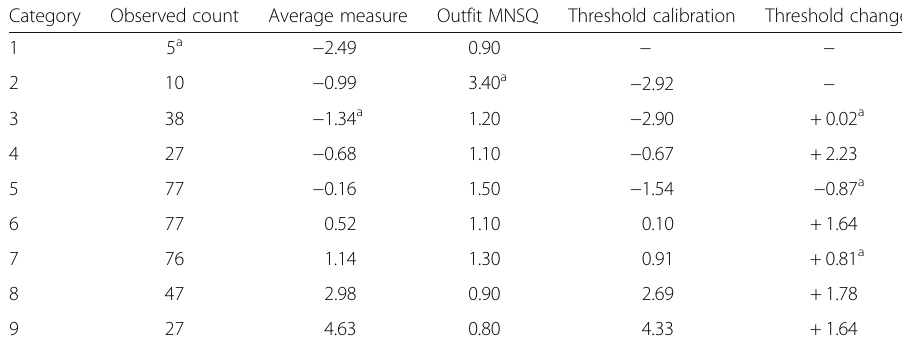
Table 2 Summary of the category structure for the 9-point interaction rating scale